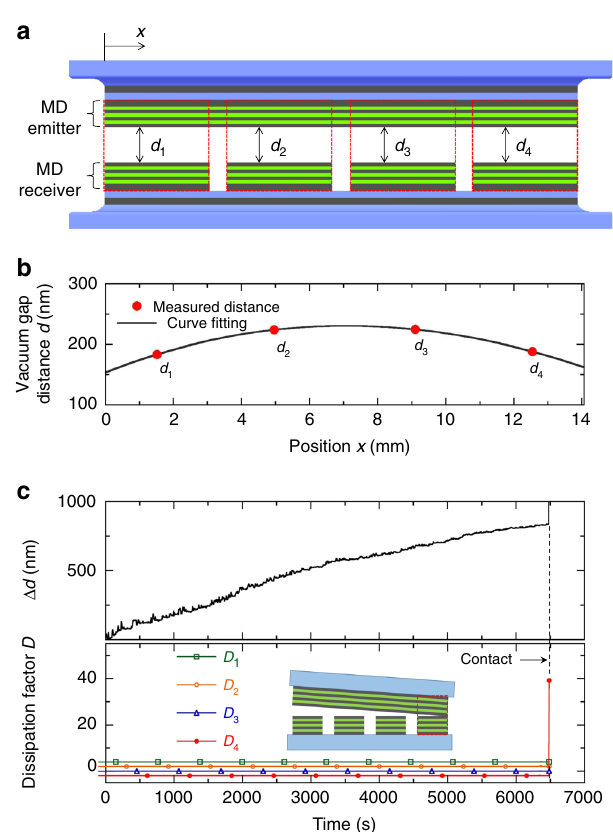
Fig. 2 Measurement of vacuum gap distance between MD emitter and MD receiver. a Schematic cross-sectional view of aligned MD emitter and MD receiver. The four local vacuum gaps can be estimated from the measured capacitances between the MD emitter and each of the divided MD receiver segments. b Measurement of four local vacuum gaps and a fi tted curve when d = 200 nm. c Upper panel: measured average vacuum gap displacement between MD emitter and MD receiver while reducing vacuum gap distance. In order to conduct steady-state measurement, the vacuum gap distance is slowly reduced by about 0.125 nm per second. Lower panel: measured dissipation factors for four segments, obtained simultaneously with results from the upper panel. The inset shows the scenario of physical contact between MD emitter and fourth MD